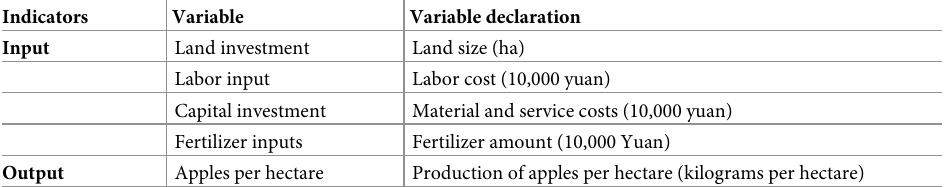
Table 1. Measuring index system of apple production